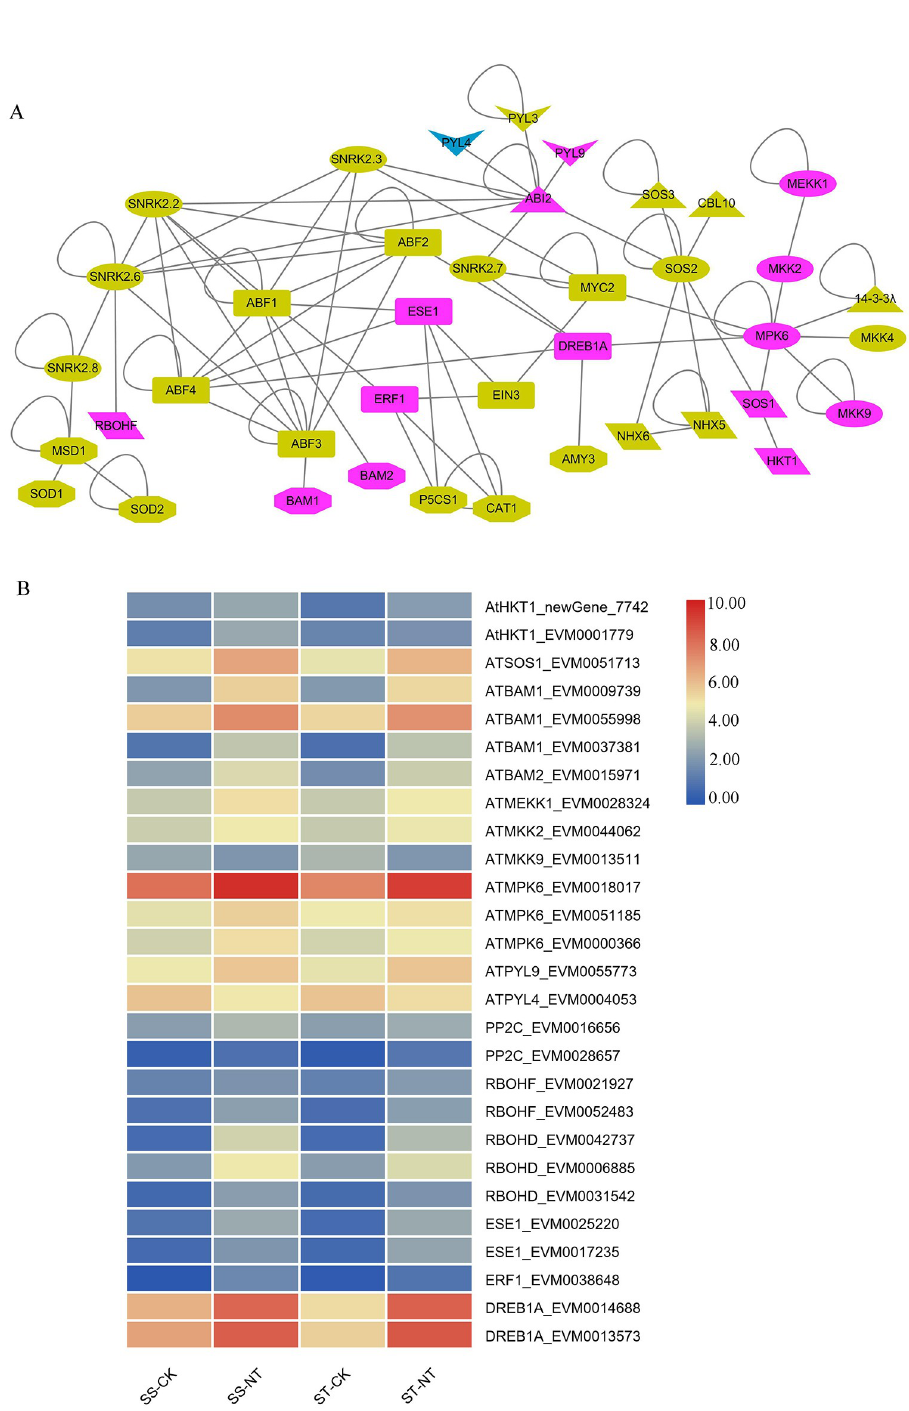
Fig 8. Verification of 9 DEGs responsive to salt stress by quantitative real-time PCR (qRT-PCR). For salt stress, 20-day hydroponic culture roots of ‘SS’ and ‘ST’ were treated with 150 mM NaCl for 4 h. The control was an untreated SS sample. Three biological replicates for each sample were performed and bars represent the standard deviations of the mean. �� p < 0.01 between treated sample and untreated control, Student’s t-test. Gene expression profiles were evaluated using the 2 − ΔΔ Ct method and the value of control was normalized to 1. SS-CK and SS-NT indicate the salt- sensitive group samples treated without and with 150 mM NaCl; ST-CK and ST-NT indicate the salt-tolerant group samples treated without and with 150 mM NaCl. DEGs, differentially expressed